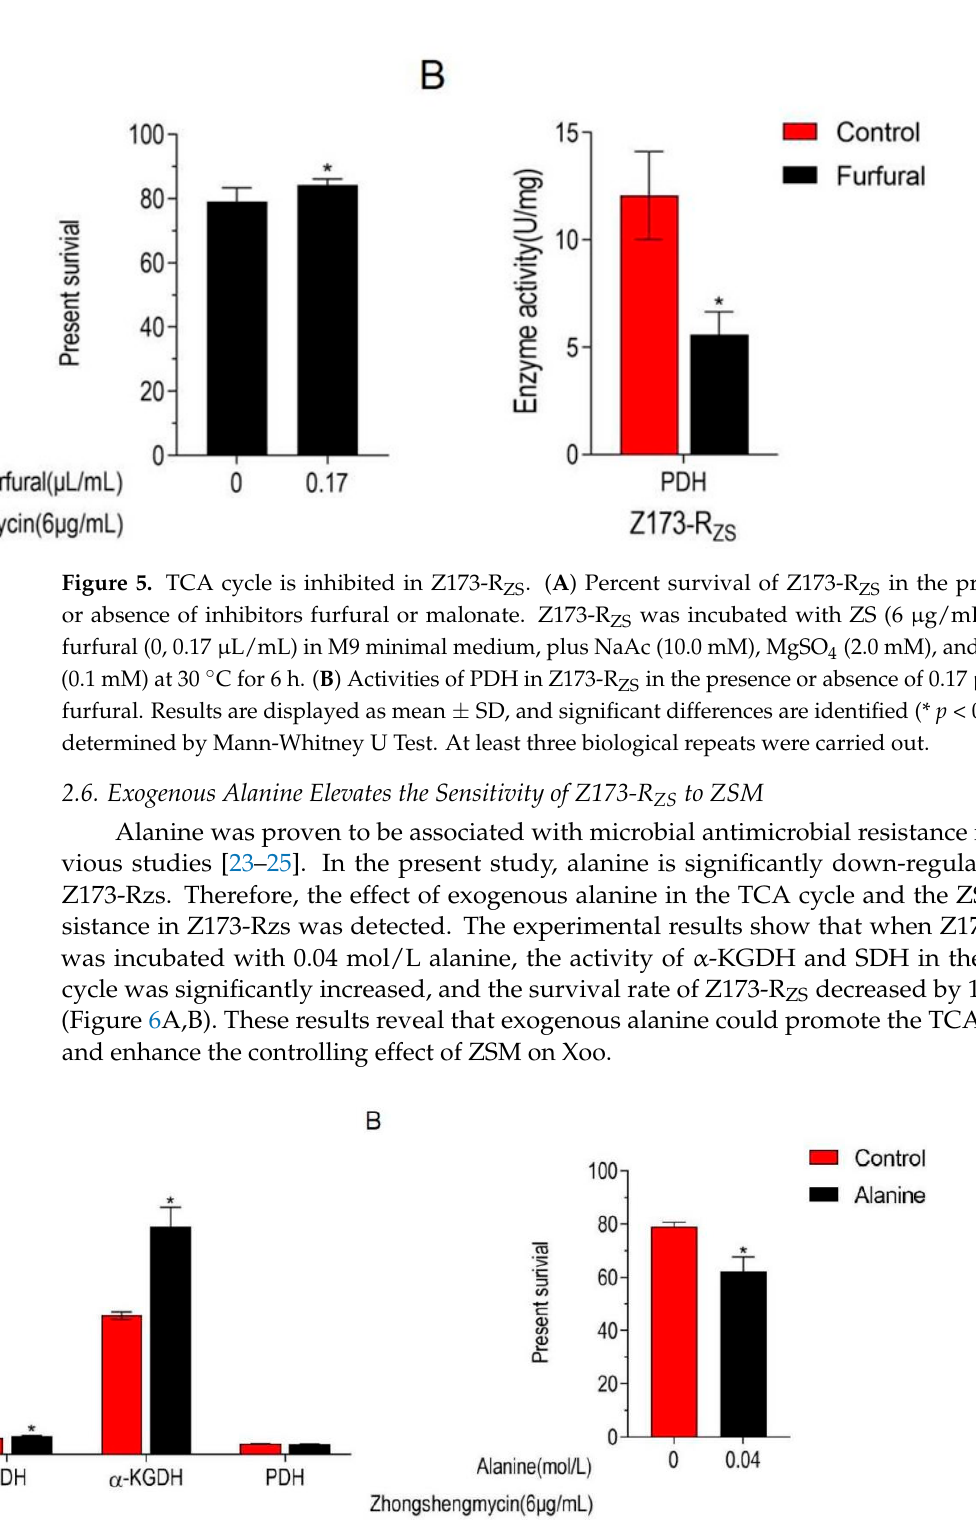
Figure 6. Alanine elevates the TCA cycle and potentiate ZS to control Z173-R ZS . ( A ) Activities of PDH, α -KGDH, and SDH in Xoo-RZS in the presence or absence of 0.04 M alanine. Results are displayed as mean ± SD, and significant differences are identified (* p < 0.05) as determined by Mann-Whitney U Test. At least three biological repeats were carried out. ( B ) Percent survival of Xoo-RZS in the presence or absence of alanine. Xoo-RZS was incubated with ZS (6 μ g/mL) plus alanine (0, 0.04 M) in M9 minimal medium, plus NaAc (10.0 mM), MgSO4 (2.0 mM), and CaCl2 (0.1 mM) at 30 ℃ for 6 h.